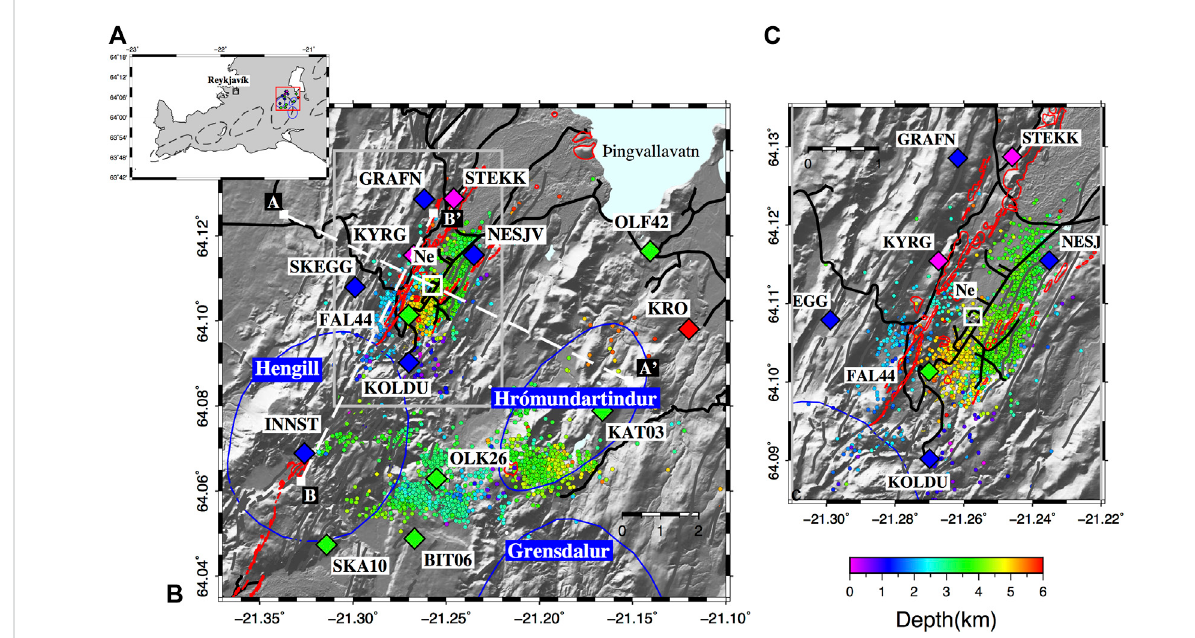
FIGURE 1 The Hengill study area: seismic stations and earthquake locations. (A) shows the location of the study area (red box) and the volcanic centers in SW-Iceland. (B) Seismic events extracted from ÍSOR ’ s catalog (2016 – 2020) and relocated using the 3D velocity model based on this study. Blue, green, magenta, and red diamonds represent the seismic stations of the ÍSOR/ON network, the COSEISMIQ and S4CE project, and the SIL seismic network deployed in the study area, respectively. AA ′ and BB ′ pro fi les, shown as white dotted lines, are discussed in the results paragraph. Relocated earthquakes (2016 – 2020) are color coded by depth. Solid blue lines are the three volcanic centers of the region with their respective names in white on a blue background. The white square marked as “ Ne ” is the Nesjavellir power plant. Black lines are the roads. Red lines